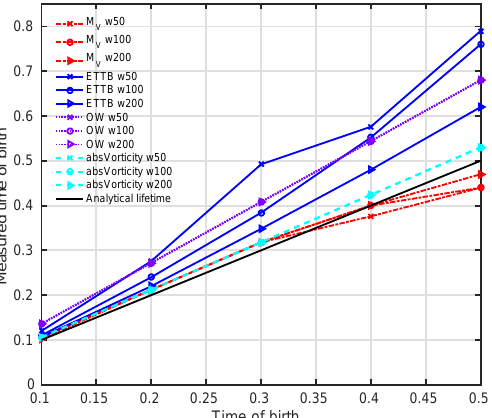
Figure 6. Measured lifetime of an eddy obtained by means of M V (red line) versus the chosen τ (analytical lifetime T c = 1 (blue line); vortex strength: